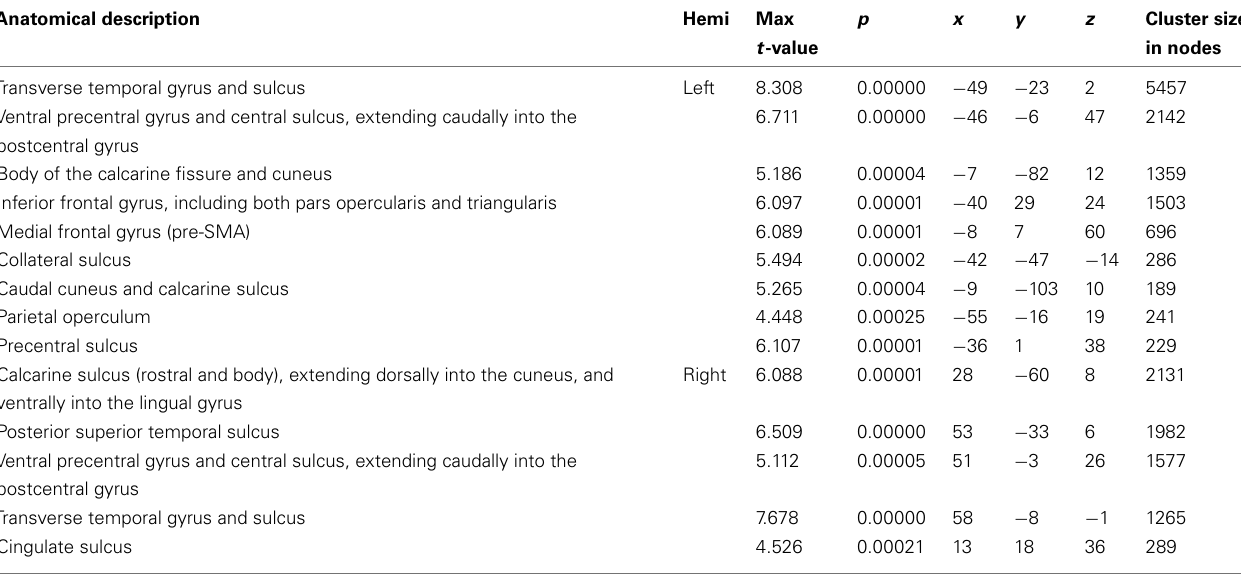
Table 4 | Family-wise error-corrected group-level ( N = 20), cortical surface results for the contrast of Sentence generation against Sentence repetition.